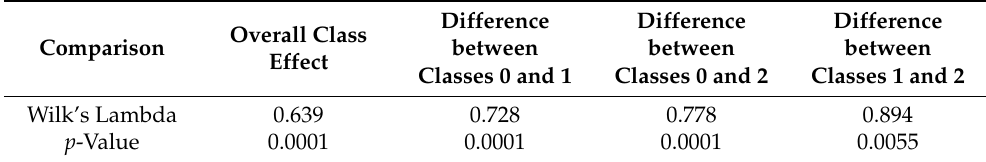
Table 6. MANOVA Test: Wilk’s Lambda for frequency of